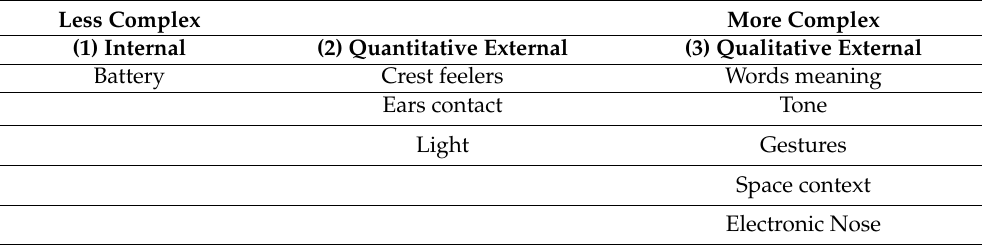
Table 1. Stimuli categorization